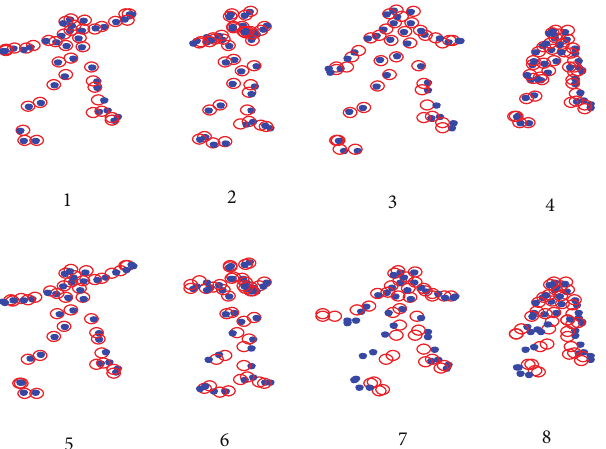
Figure 5: 3D reconstruction results on the “Yoga” sequence with two methods, respectively. The red dots denote the ground truth coordinates and the blue circles denote the estimation coordinates. The top row is the reconstruction result with sparse approximation and the bottom row is with the DCT trajectory basis method. Both of the results of these two methods are shown with the 1 (better viewed in color).